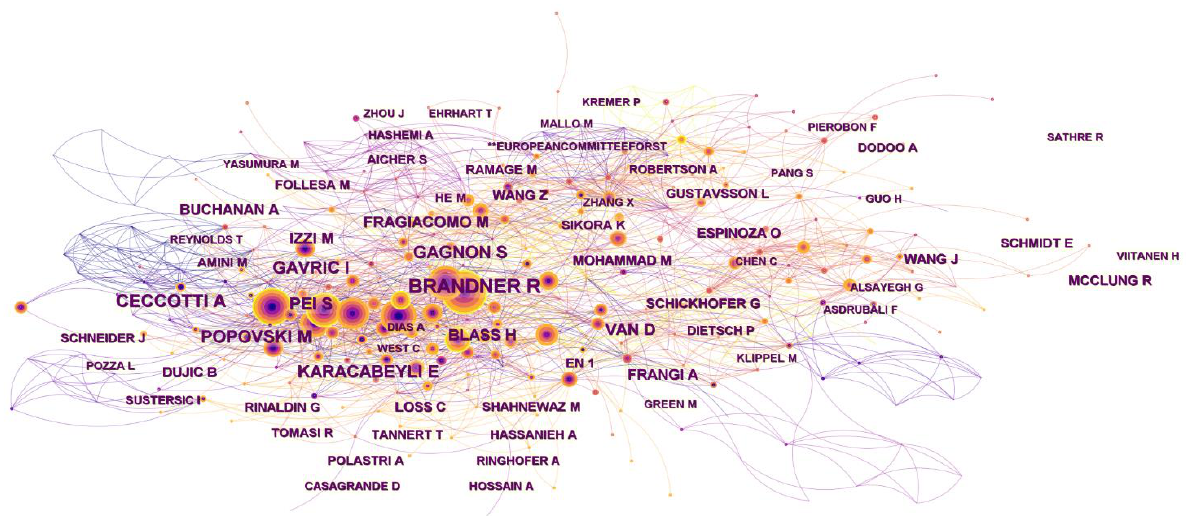
Figure 8. Author co-citation network for publications of cross-laminated timber in construction.